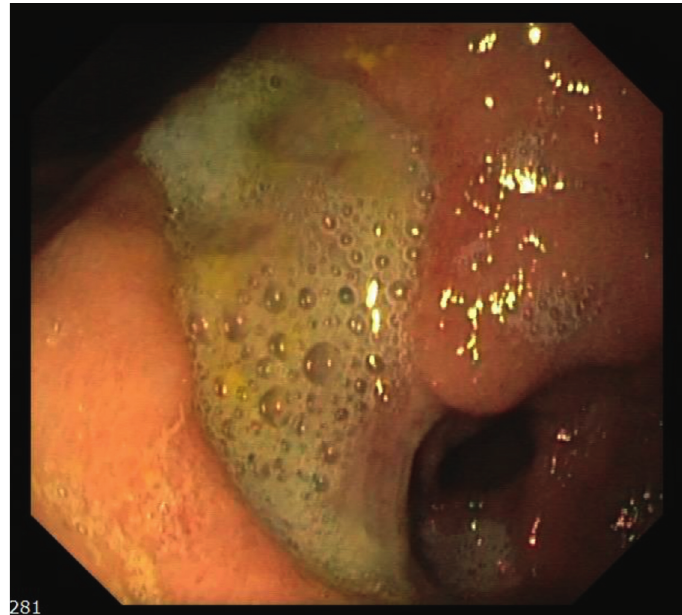
Figure 1: Endoscopy showing the gastric ulcer.